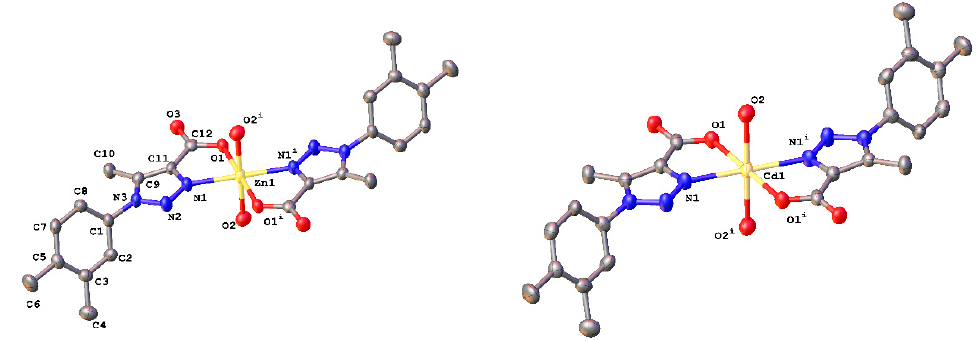
Figure 2. ORTEP plot for compounds 1 (left) and 2 (right). Hydrogen atoms were omitted for the sake of clarity. Thermal ellipsoids were drawn with a 30% of probability. Symmetry code: (i) x , y , z .